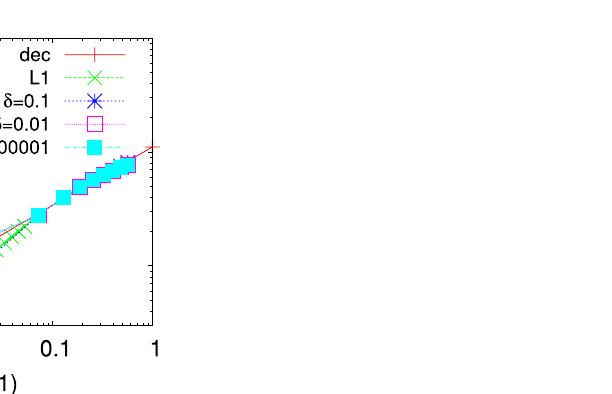
Figure 1. The TNR/TPR ratio vs. the regularizer λ used for the  undecimated couplings for the PLM with decimation. The stopping point indicates the maximum of  where the decimation procedure stops. In the first case two different criteria are chosen to eliminate small bonds: the a - priori δ thresholding or the a posteriori inferred bond distribution thresholding based on the Fisher information matrix (see Suppl. Mat. for details). Data are taken from a 4 XY model on a sparse Erdos-Renyi random graph with N q = N , N = 16, T = 1.3, M = 1024. In this case the finite size proxy for the critical temperature is